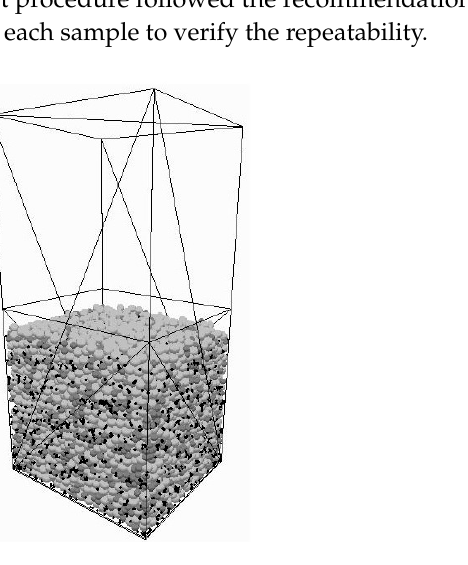
Table 3. Values of f k along with N k and N in mixtures with g = 1.25 and 3.75 and PSD nonuniform by number of spheres.